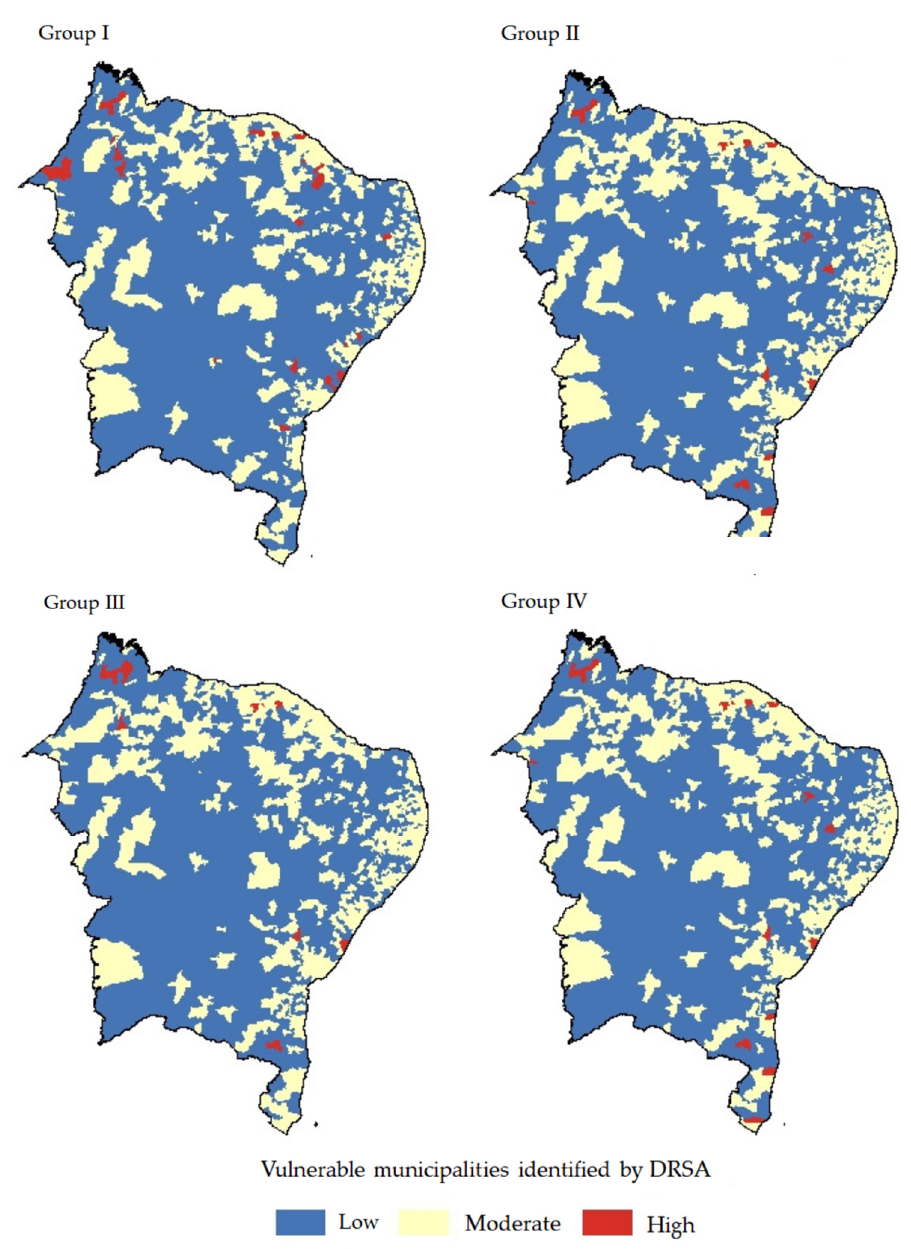
Figure 3. Classification results from DRSA. Each group describes the classification from DRSA decision rules, considering the reference examples.